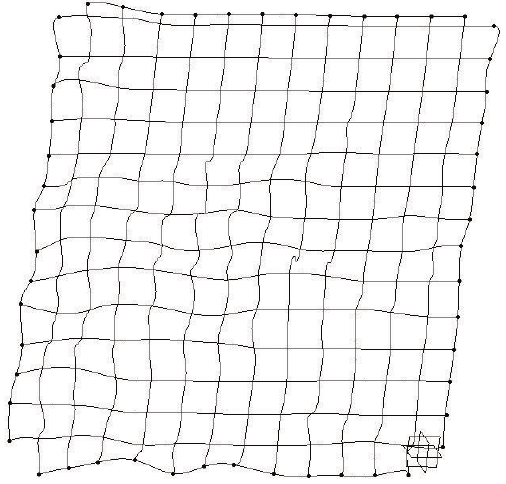
Figure 8: The skeleton frame of kinetic energy distribution surface.